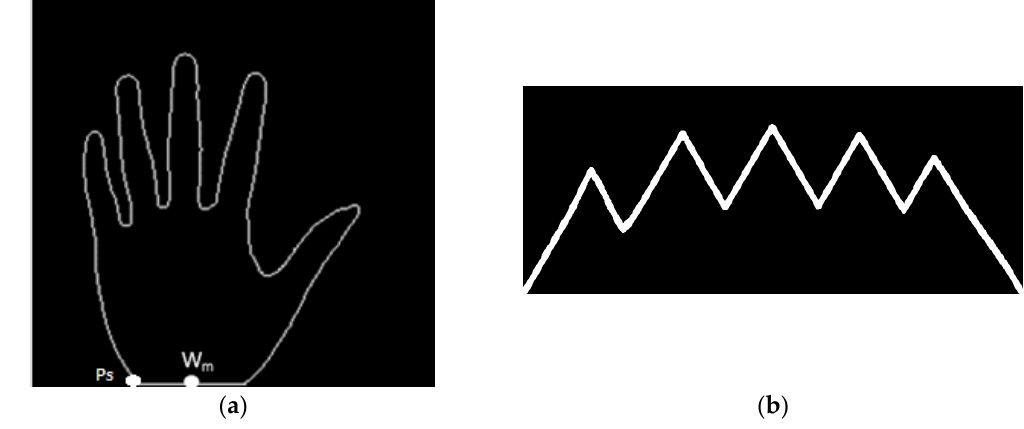
Figure 4. ( a ) Contours of the palm region; ( b ) Distance distribution profile of the palm contours constructed using the Euclidean distances between the wrist middle point W M and palm contour pixels.